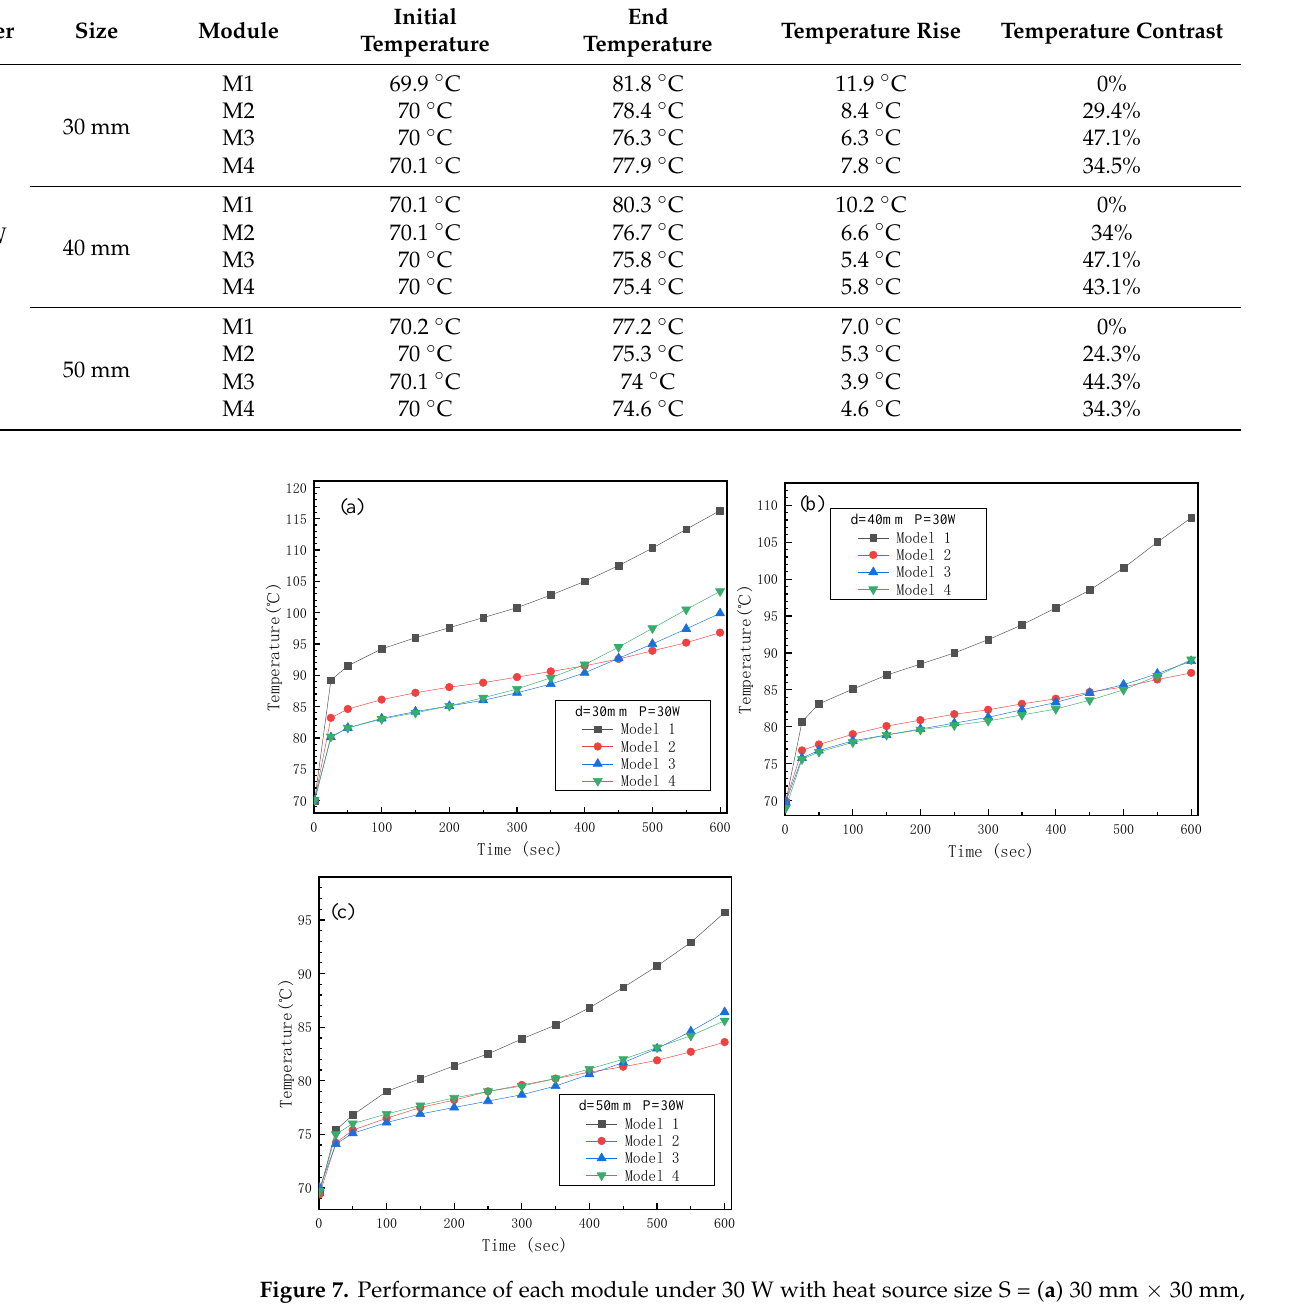
Figure 7. Performance of each module under 30 W with heat source size S = ( a ) 30 mm × 30 mm, ( b ) 40 mm × 40 mm, and ( c ) 50 mm × 50